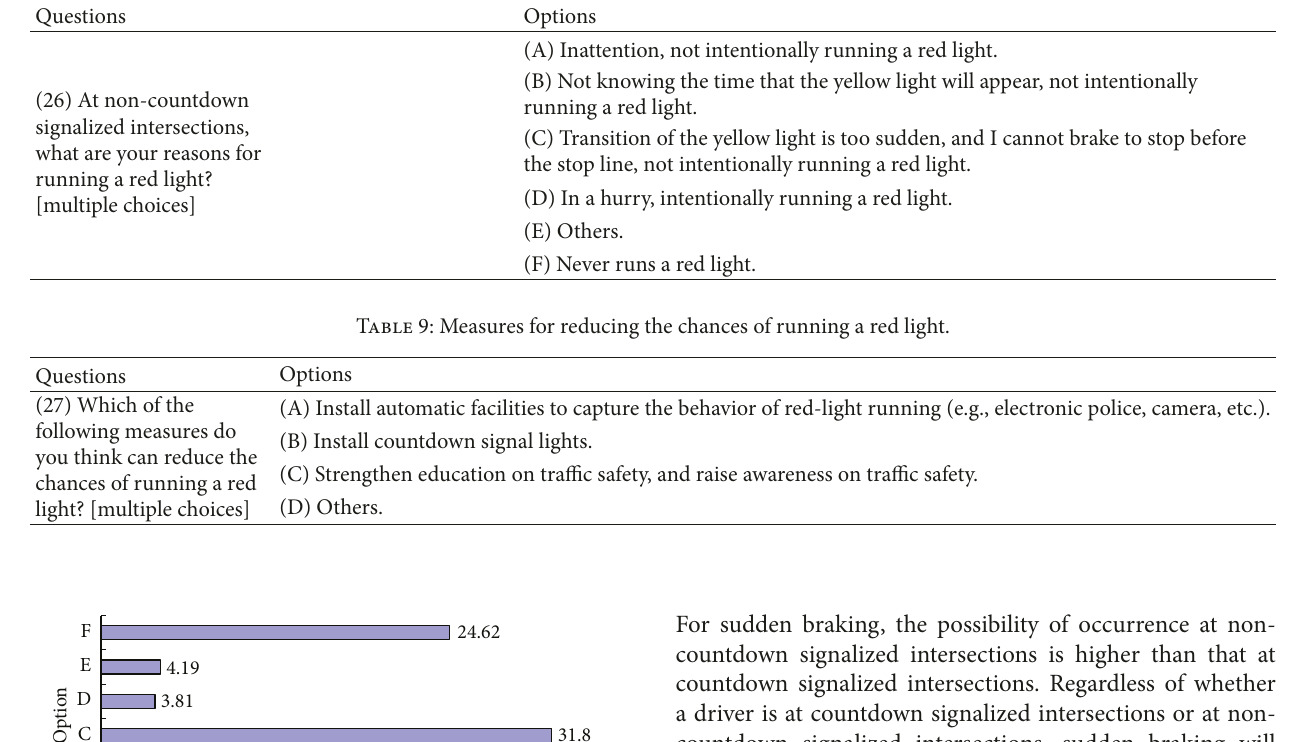
Table 8: Reasons for running a red light at non-countdown signalized intersections.